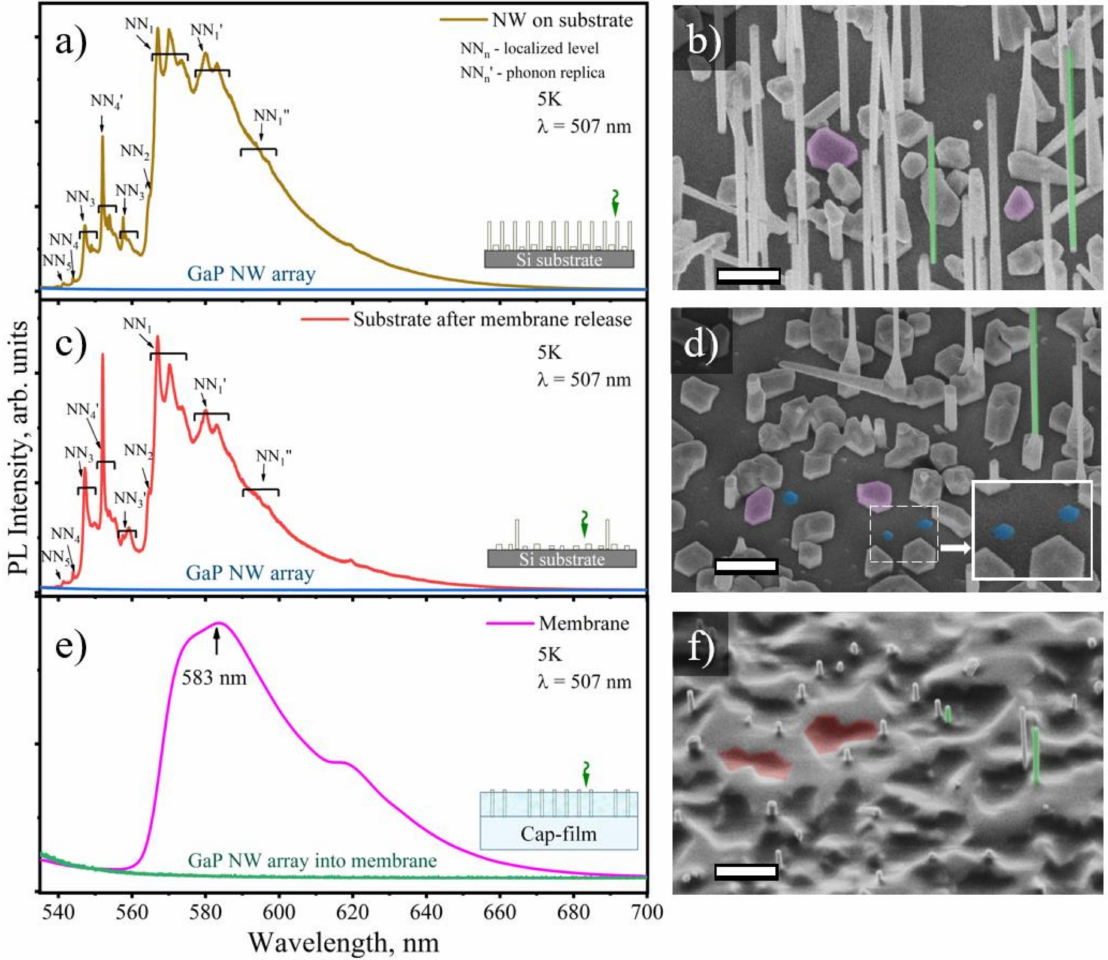
Figure 5. ( a , c , e ) Low-temperature PL response measured on ( a ) the as-grown GaPN / GaP NWs array on Si(111), ( c ) the growth substrate after membrane release, ( e ) the exfoliated NW / membrane (insets illustrate experiment geometry); ( b , d , f ) corresponding inclined-view (45 ◦ ) sample surface SEM images (scale bar—1 µ m), corresponding zoomed area presented in inset of ( d